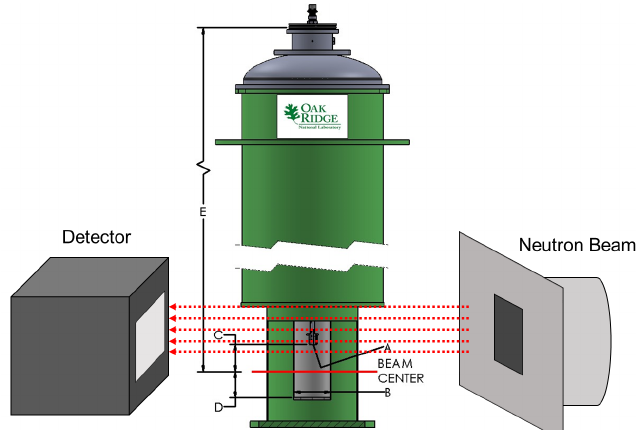
Figure 2. Diagram of the experimental setup at the CG-1D beamline at the High Flux Isotope Reactor (HFIR) at Oak Ridge National Laboratory. The image depicts the high-vacuum Institut Laue-Langevin (ILL) HOT-A furnace placed between the detector and the incident neutron beam slits. (A) Interface connection M8 × 1.25 (male), (B) Bore size diameter = 50 mm, (C) Distance interface to beam center = 31.75 mm, (D) Beam center to sample space bottom = 11.862 cm, E) Distance stick flange to beam center = 41.275 cm. Image of ILL furnace ‘HOT-A’ courtesy of Oak Ridge National Laboratory Sample Environment